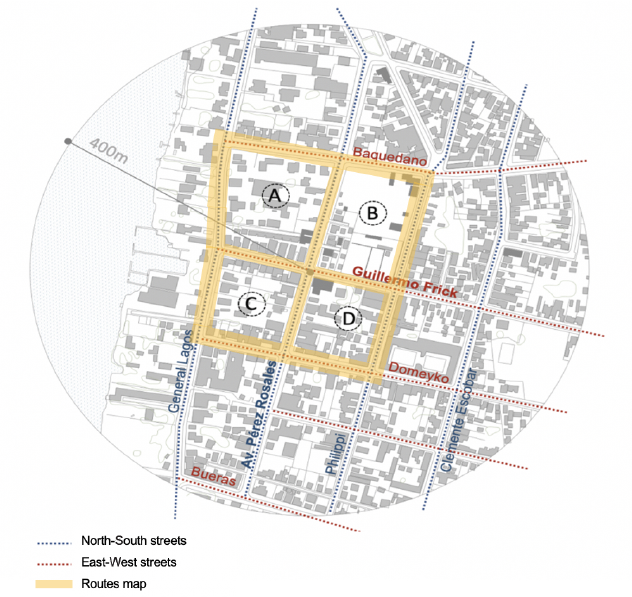
Figure 4. Morphological street analysis around Prince of Asturias school Table 3. Dimensions of the urban block examined in the study Urban